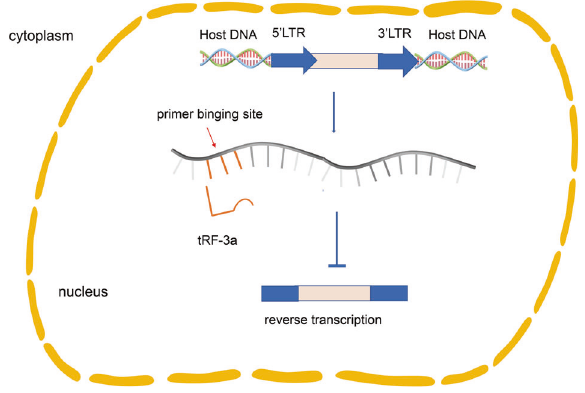
Fig. 6 The function of tsRNA on virus infection. tRF-5s recognize the target site in the 3 ’ UTR of apolipoprotein E receptor 2 (APOER2) mRNA. The suppression of AROER2 translation could promote RSV